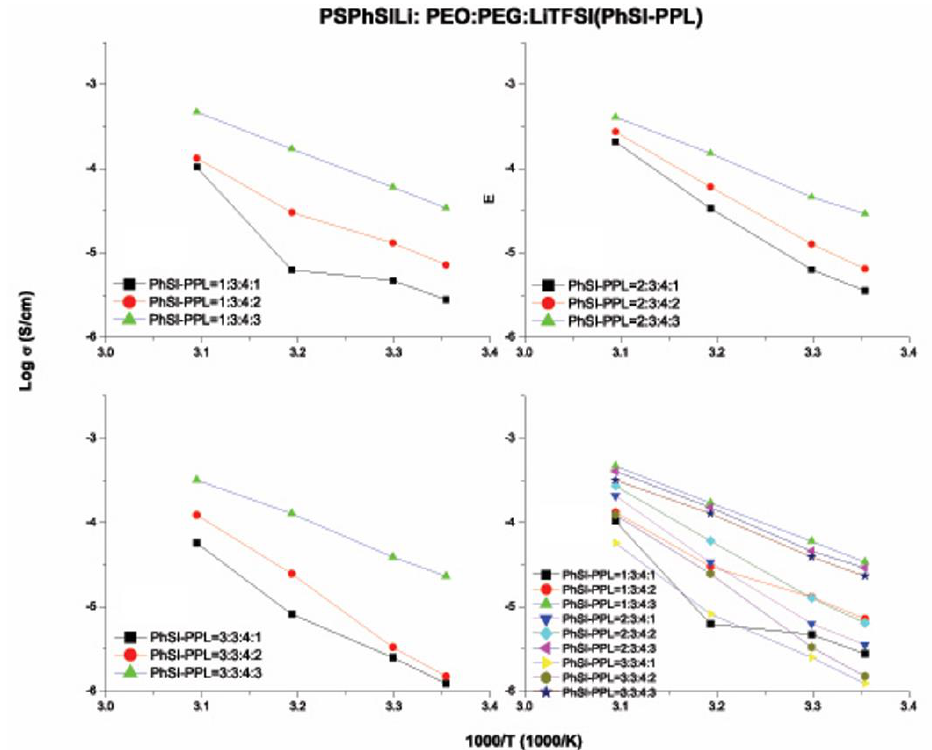
Figure 12. Ionic conductivity versus temperature of various weight ratios of PSPhSILi–PEO–PEGDM– LiTFSI (PhSI–PPL) electrolytes.